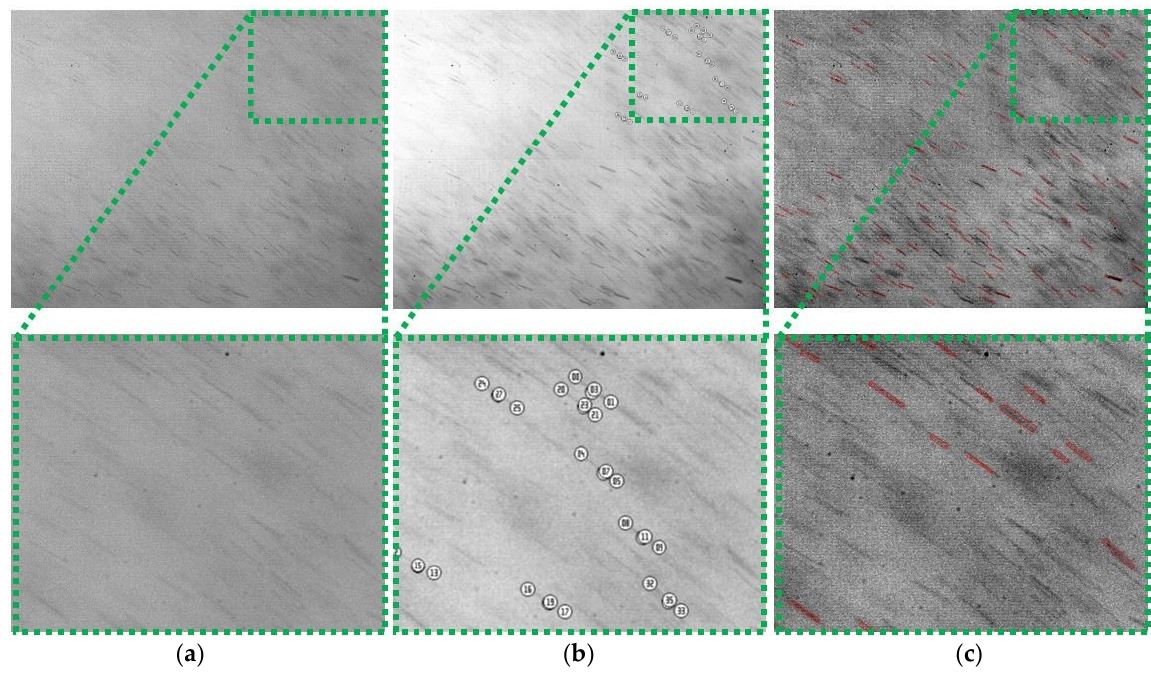
Figure 3. High-speed visualization and analysis of droplets: ( a ) original image, ( b ) enhancement and visual recognition, and ( c ) enhancement and computer algorithm recognition. In all columns, the original image is presented in the upper row and an approximately three times magnification of the image is shown in the lower row.